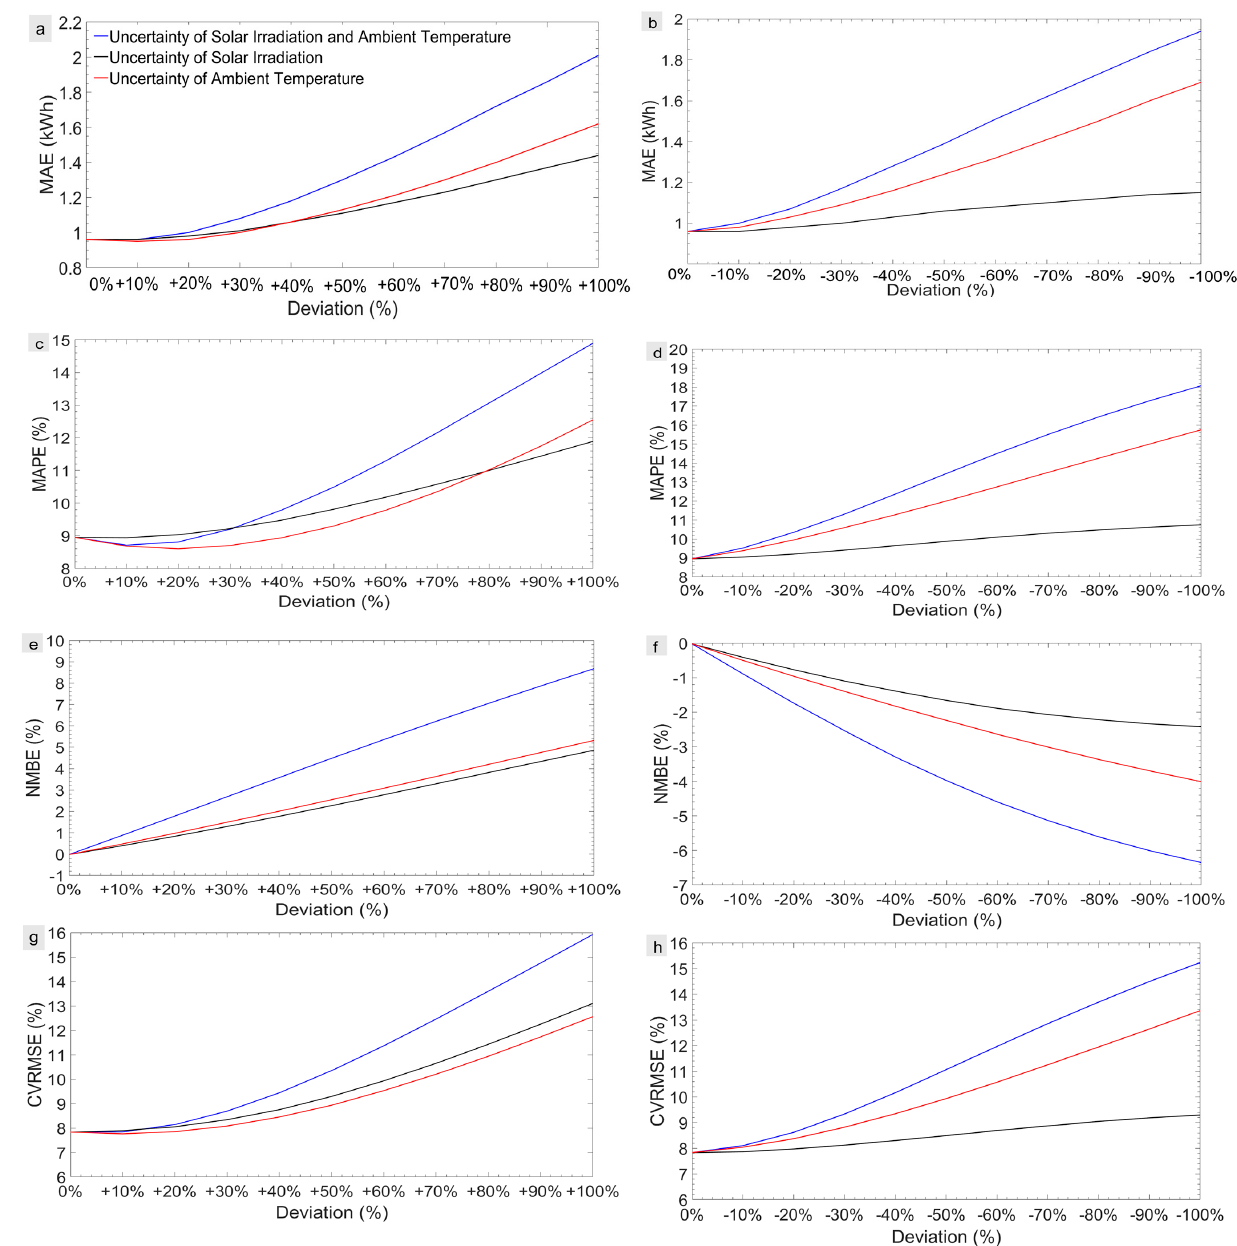
Figure 8. Impact of weather uncertainty on the accuracy of forecasting approach ( a ) MAE-Positive Deviation ( b ) MAE-Negative Deviation ( c ) MAPE-Positive Deviation ( d ) MAPE-Negative Deviation ( e ) NMBE-Positive Deviation ( f ) NMBE-Negative Deviation ( g ) CVRMSE-Positive Deviation ( h ) CVRMSE-Negative Deviation.